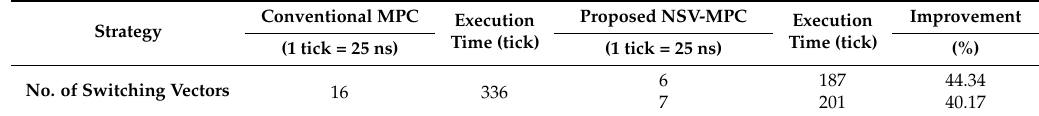
Table 5. Execution time measurement.